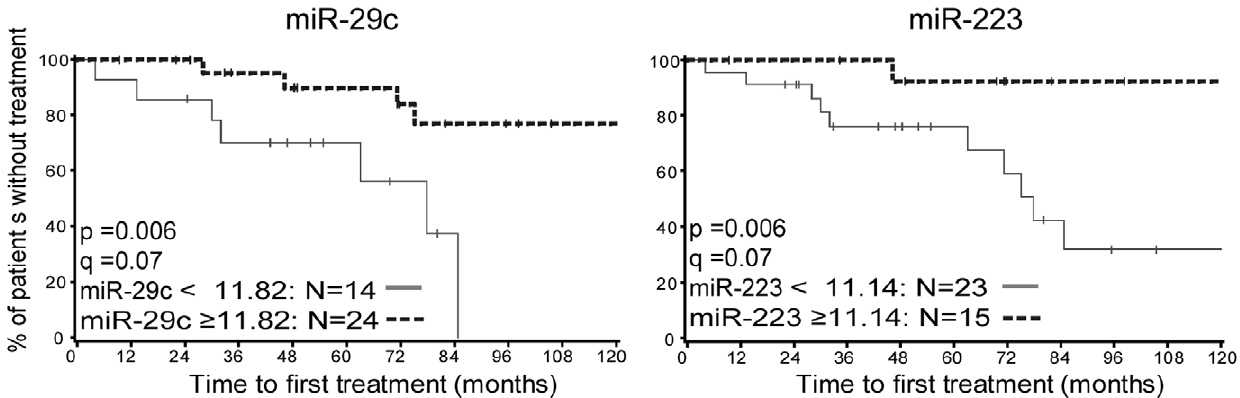
Figure 4. The expression of miR-29c and miR-233 is associated with time to first therapy in CLL. A shorter time from diagnosis to initiation of first therapy is significantly associated with reduced expression of miR-29c and miR-223. A recursive partitioning approach identifies the optimal split for each miRNA: miR-29c expression at 11.82 or lower is associated with shorter time to first therapy, q =0.07. miR-223 expression at a level of 11.14 or lower is associated with shorter time to first therapy, q =0.07.